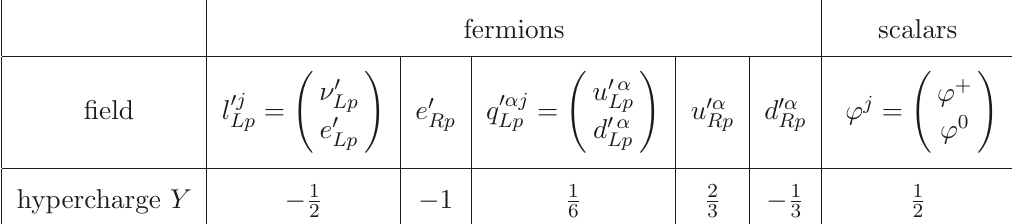
Table 1 . The SM matter content in the gauge basis. Isospin, colour and generation indices are indicated with j = 1 , 2, α = 1 . . . 3 and p = 1 . . . 3,